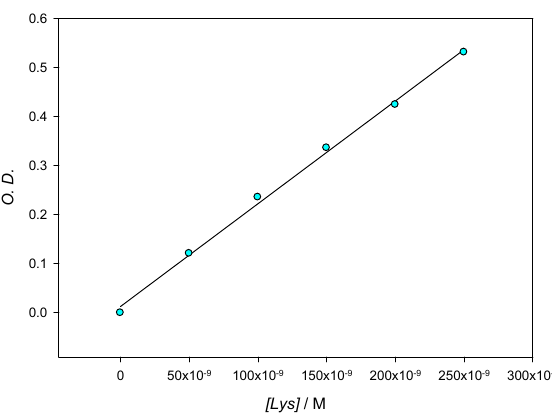
Figure 3. Optical density at different Lys concentrations for a constant ratio [AuNPs]/[Lys] = 0.0164 measured at 565 nm.